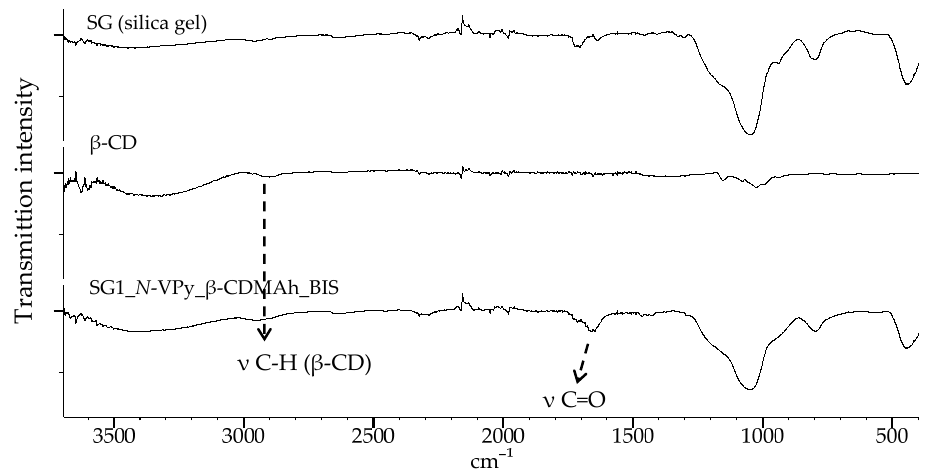
Figure 6. ATR-IR spectra (from the top-down): silica gel; β -CD; SG2_ N- VPy_ β -CDMAh_BIS; SG2_St_ β -CDMAh_EGDMA. Comparing these two spectra reveals that the ratio of the intensities of the polymer peaks to the silica gel signals is higher for the sorbent where the polymer was adhered on the silica gel activated via method 2. It can therefore be assumed that the second method of silica gel activation is more effective and allows a greater amount of the polymer to be introduced on the silica surface. Therefore, this approach was applied to prepare the second type of sorbent, which contained styrene units in addition to cyclodextrin units (SG2_St_ β -CDMAh_EGDMA). In all IR spectra of the obtained sorbents (Figures 5 and 6), a weak band originating from the C – H stretching vibrations in the β -CD molecules appears at about 2883 cm − 1 (for the SG2_St_ β -CDMAh_EGDMA sorbent this band is shifted slightly toward smaller wave numbers). In addition, characteristic signals from the stretching vibrations of carbonyl bonds are visible. For SG2_St_ β -CDMAh_EGDMA sorbent, characteristic signals indicating the presence of an aromatic ring are visible.